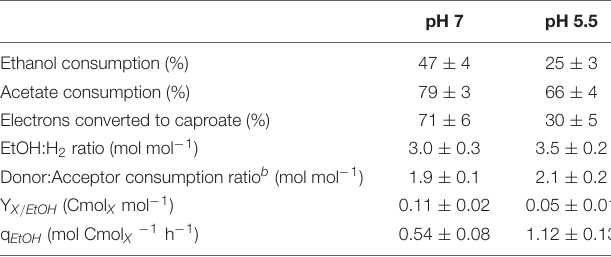
TABLE 1 | Average stoichiometric and kinetic properties of chain elongating communities in SBRs at different pH during stable operation a